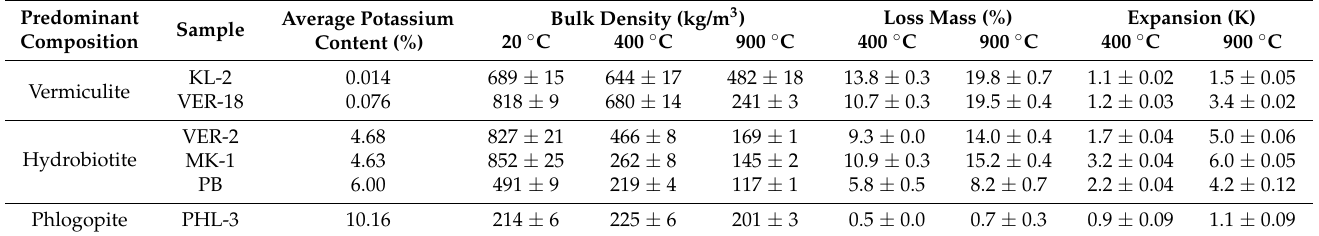
Table 3. Relationship between vermiculite composition and its properties when heated [19].